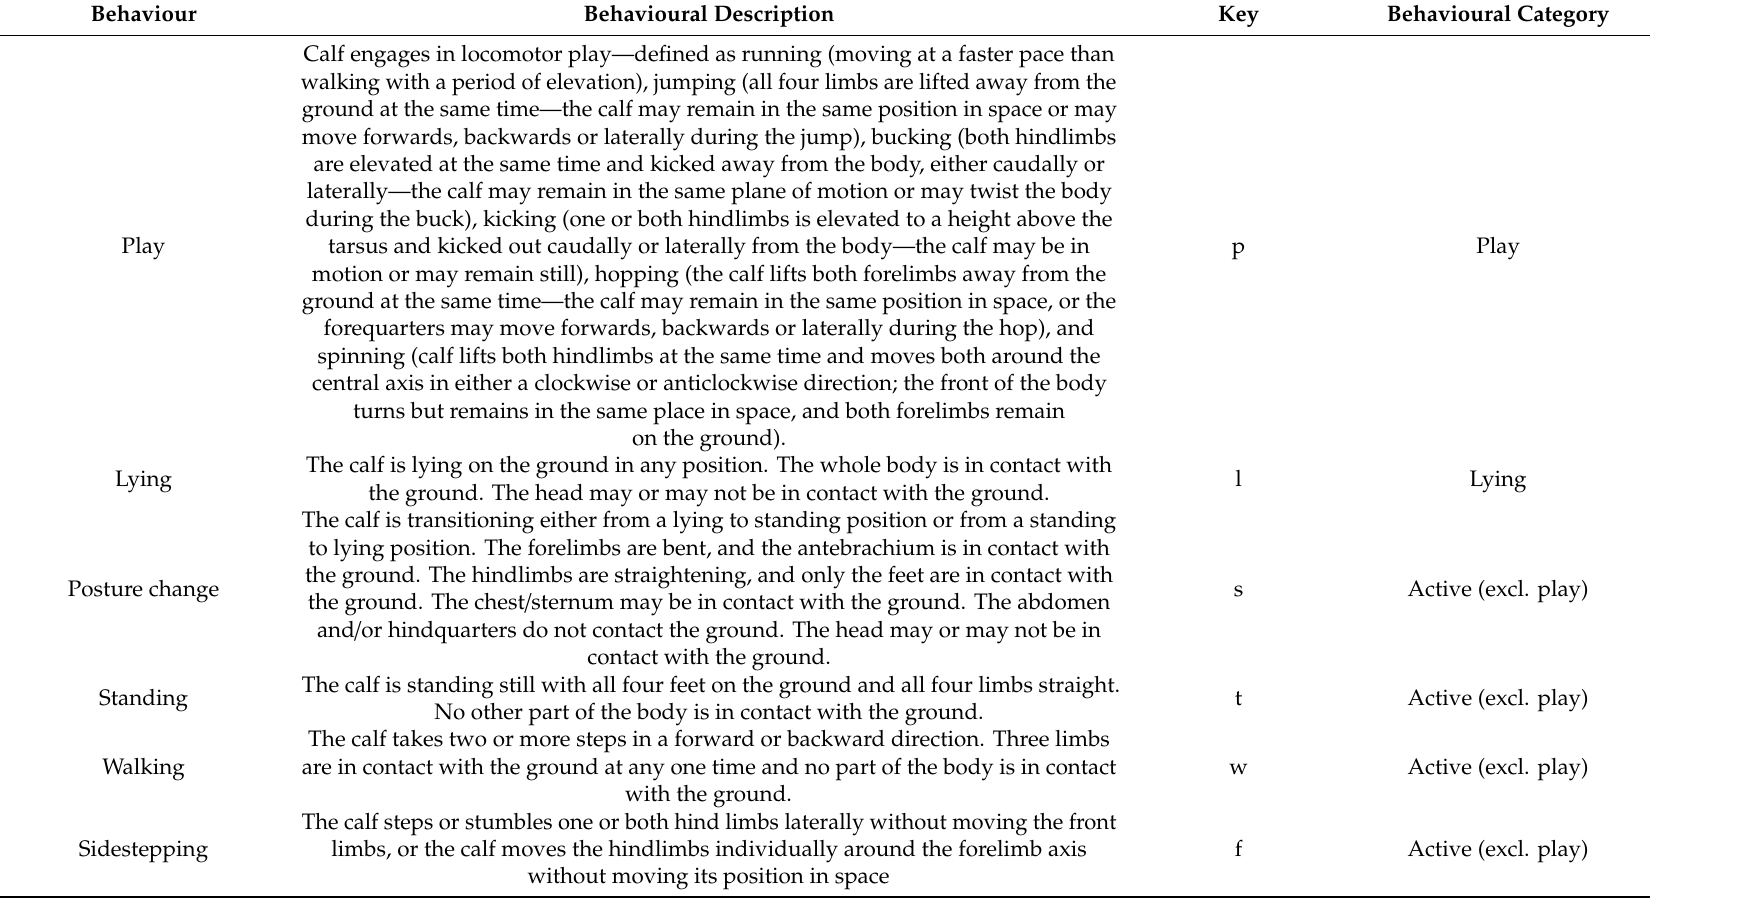
Table 2. Simplified ethogram of calf behaviours applied to one-zero sampling with a focus on the presence / absence of locomotor play behaviour in selected sample